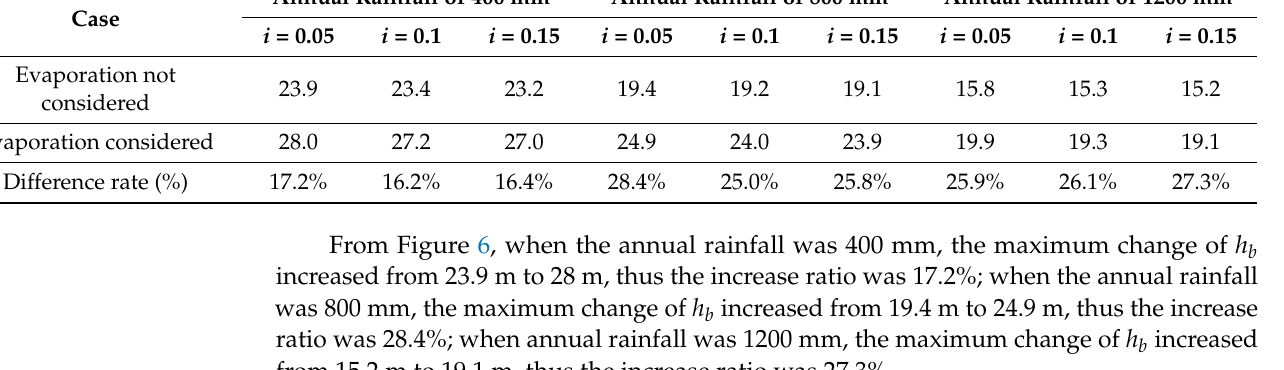
Figure 14. Saturation line of RSSF considering evaporation effect: ( a ) i = 0.05; ( b ) i = 0.1; ( c ) i = 0.15. The minimum burial depth ( h b ) of the phreatic line is defined as the minimum dis ‐ tance from the dam surface of the tailings dam to the phreatic line. As shown in Figure 14a, h b is an important index for evaluating the safety of the seepage field of the tailings